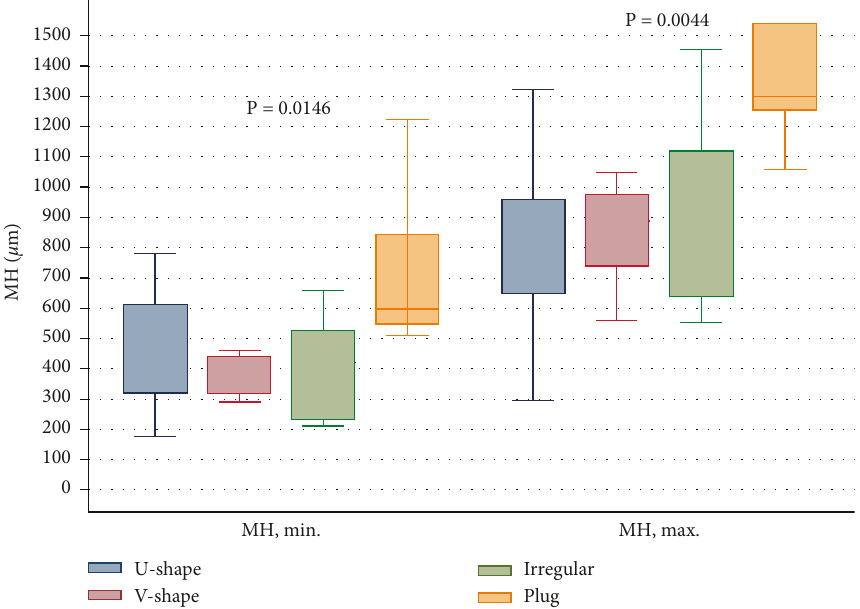
Figure 4: Correlation between minimal and base diameters and foveal contour at the final